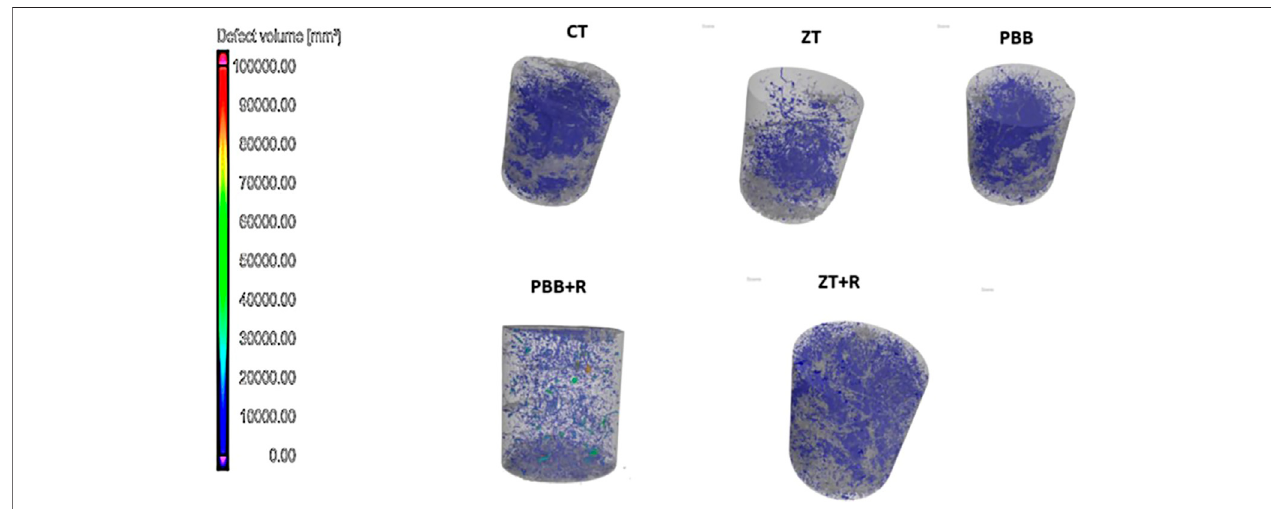
FIGURE 2 | Three dimensional view of the pore characteristics of a soil core (5 – 15 cm layer) under conventional tillage (CT) and zero tillage practices with residue (ZT + R), without residue (ZT), permanent broad bed (PBB), and PBB residue (PBB + R).